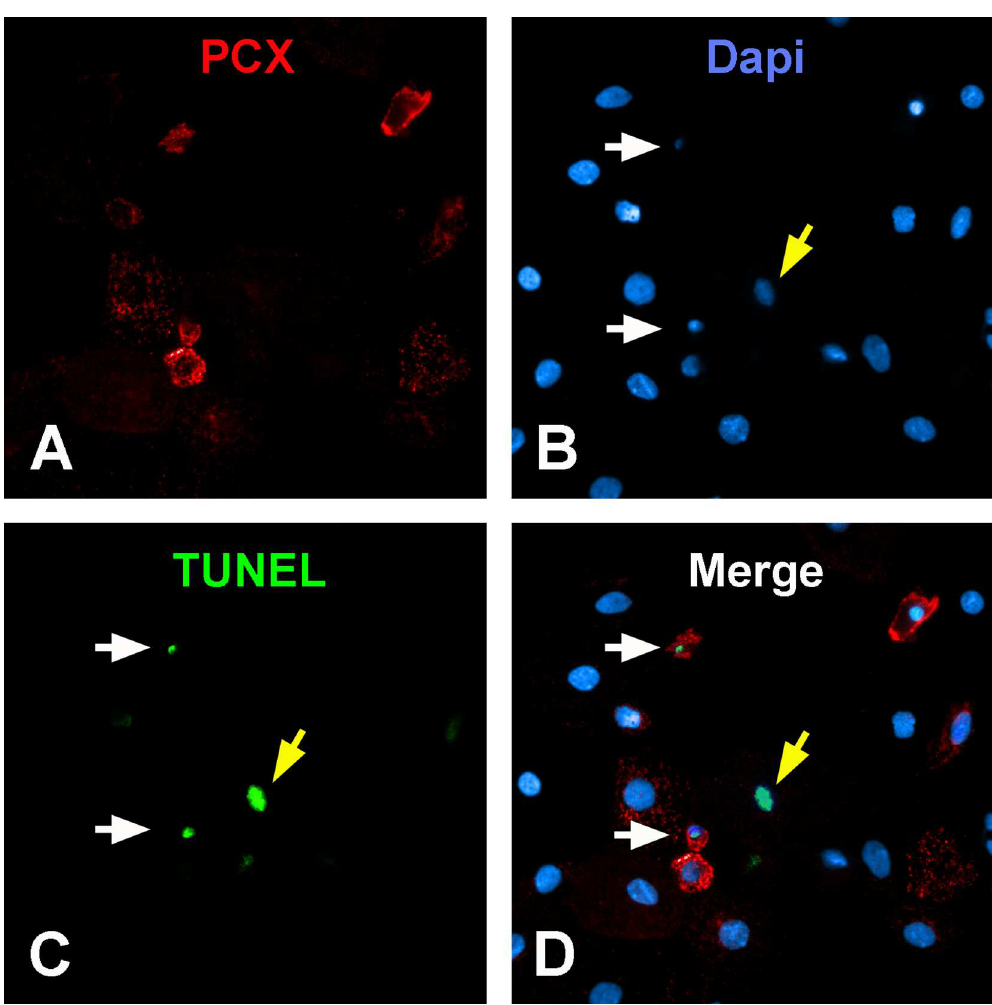
Fig 2. Urine cells on cytospin stained for podocalyxin (PCX, red), Dapi (blue), and TUNEL (green). Two podocytes(PCX+) with apoptoticnuclei (white arrows in B-D) are also positive for TUNEL (white arrows in C-D), confirmingapoptosis.The yellow arrow (B-D) shows a non-podocyte cell (PCX-) that is TUNEL+